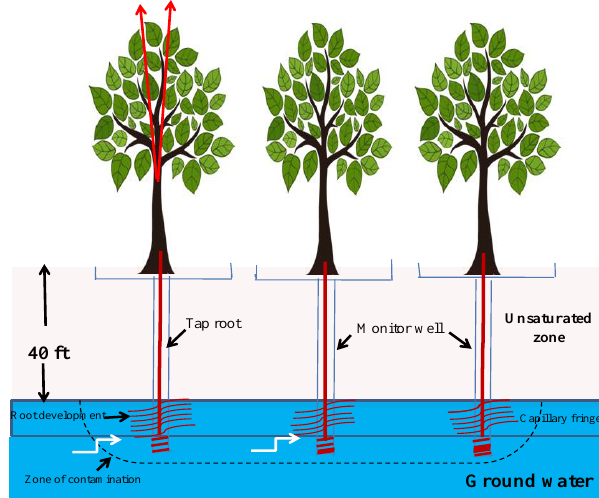
Figure 7. Mechanism of phytohydraulics.